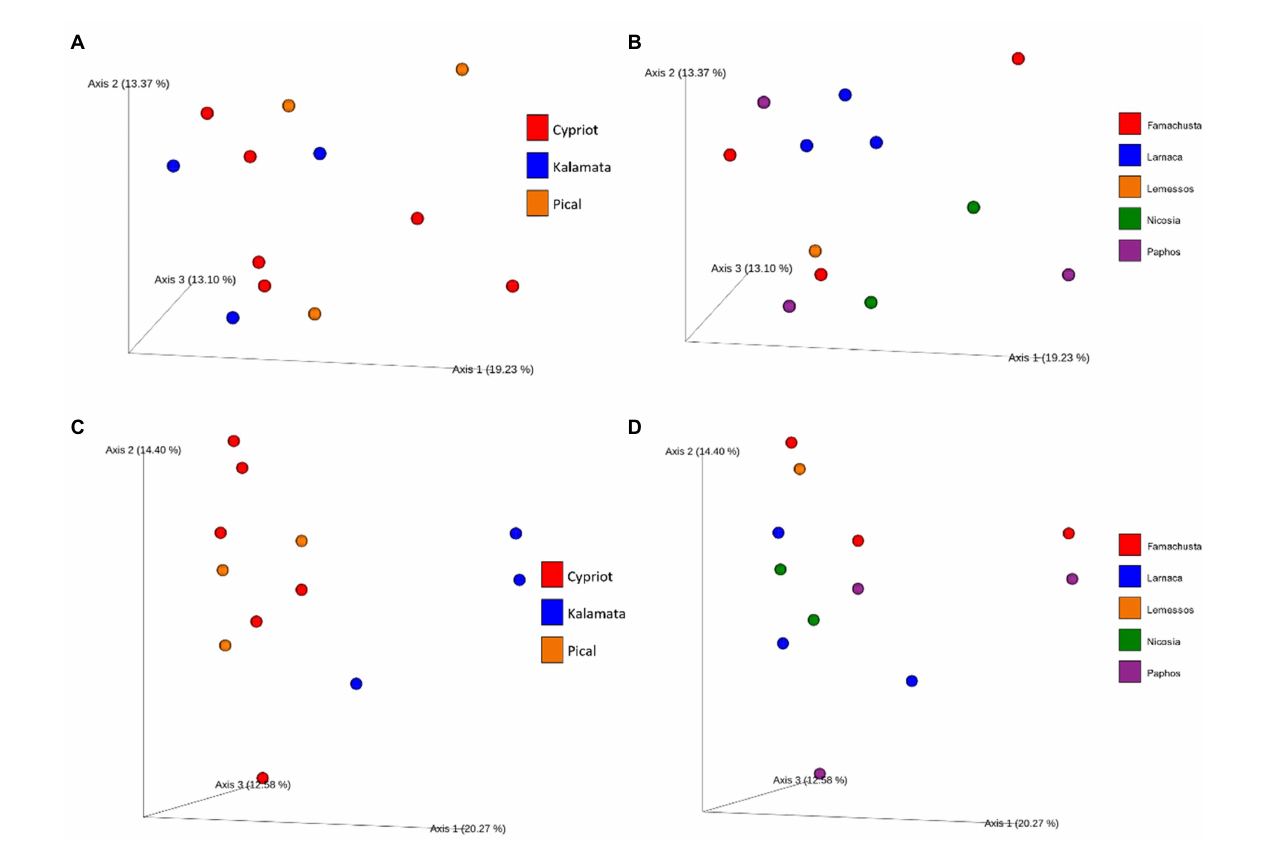
FIGURE 3 Principal coordinate analysis (PCoA) plot based on unweighted UniFrac distance. Different color corresponds to different varieties (A) or different regions (B) regarding bacterial and different varieties (C) or different regions (D) regarding fungal beta